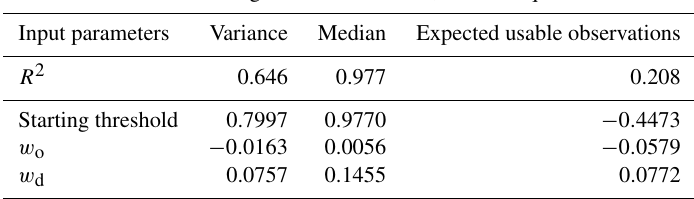
Table 4. The SRCs show that the median and variance of global error distributions are not sensitive to different weighting of the distance and overlap terms. R 2 < 0 . 7 usually signifies insensitivity to independent